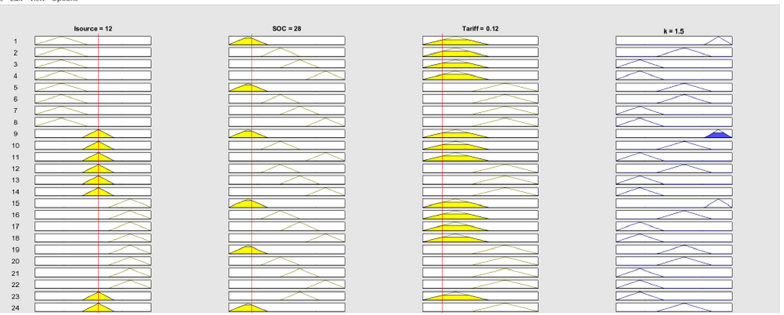
Figure 11. Rule viewer with medium source current, SoC very low, and low grid tariff with K = k3.